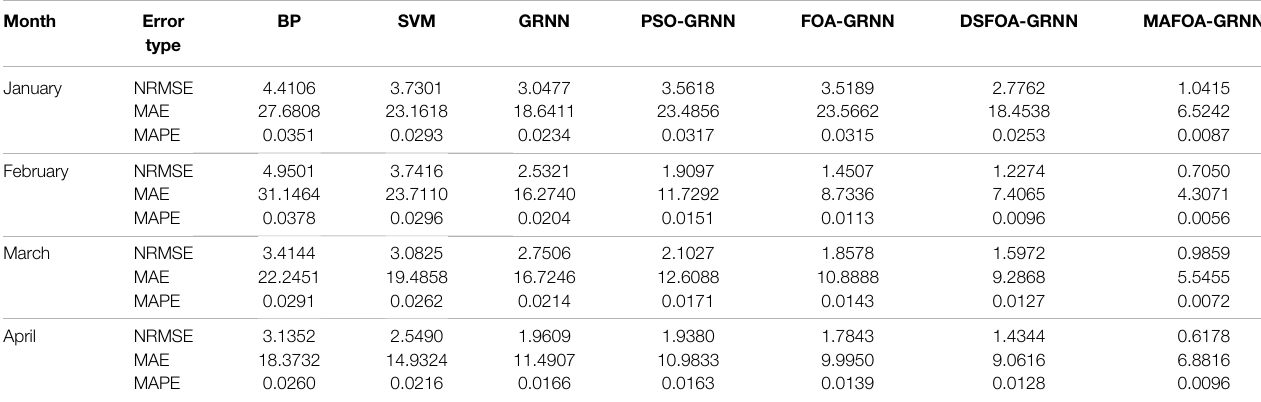
TABLE 5 | Error comparison between MAFOA-GRNN and the benchmark models.